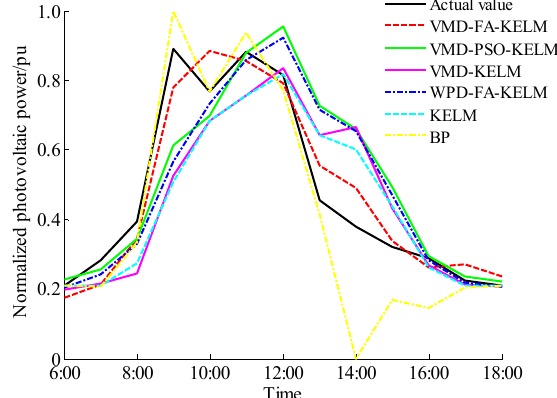
Figure 10. Point prediction of rainy day under different optimization algorithms.